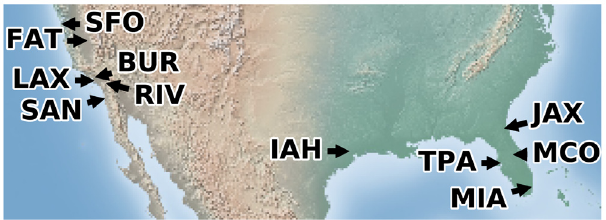
Figure 1. Locations of sites analyzed. Labels correspond to last three letters of the weather station callsigns in Table 1.